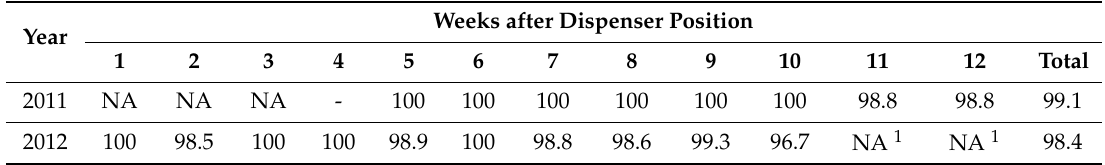
Table 2. Ratio of catches reduction (%) in the pheromone-treated (mating disruption) area with respect to the pheromone-untreated (control) area in 2011 and 2012.